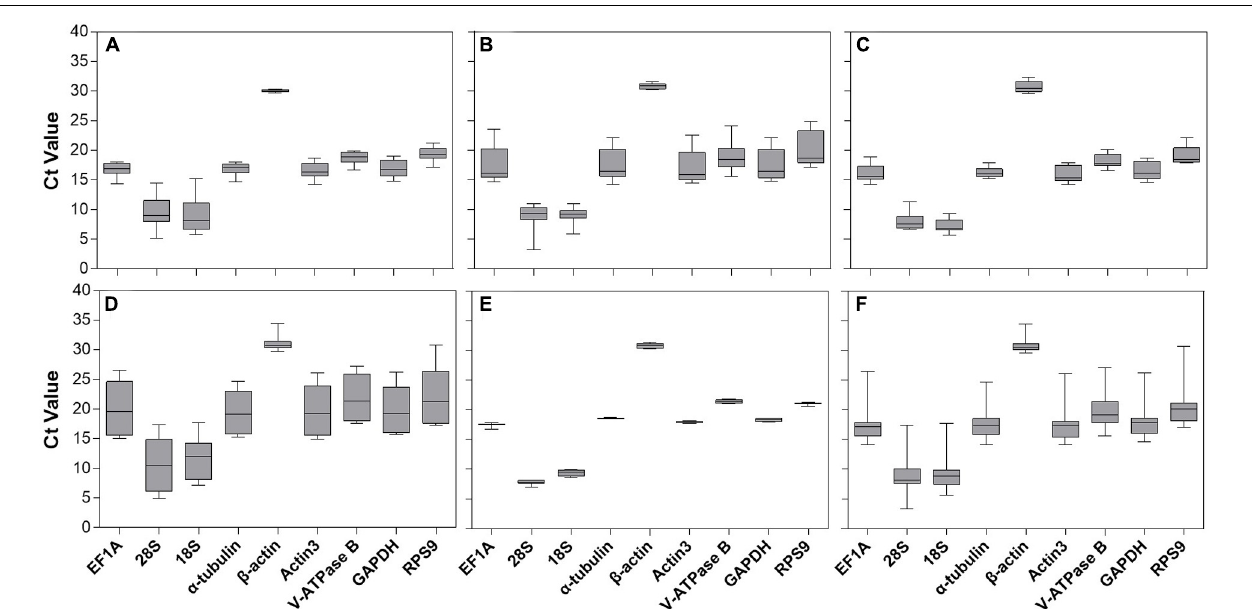
FIGURE 1 | Expression range of Ct values of nine candidate reference genes under different experimental conditions in A. viennensi . The extrinsic conditions including temperature (A) , humidity (B) , photoperiod (C) , host plant (D) , dietary RNAi (E) , and all the selected extrinsic conditions (F) . The box indicates the 25th and 75th percentiles, the line across the box represents the median, and whisker caps the maximum and minimum values.